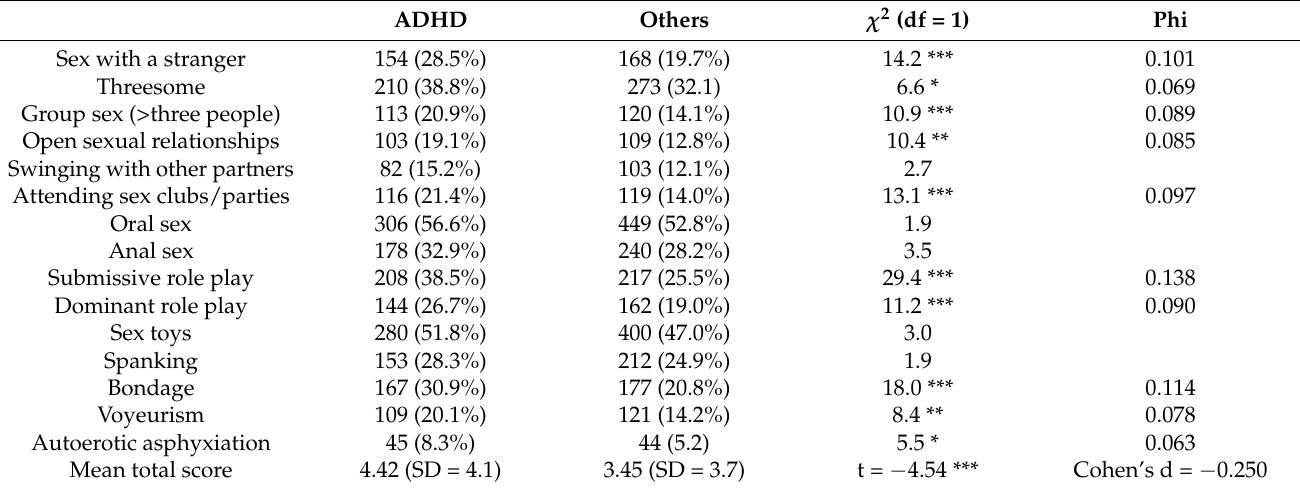
Table 9. Differences in sexual interests between ADHD and Other participants ( n =